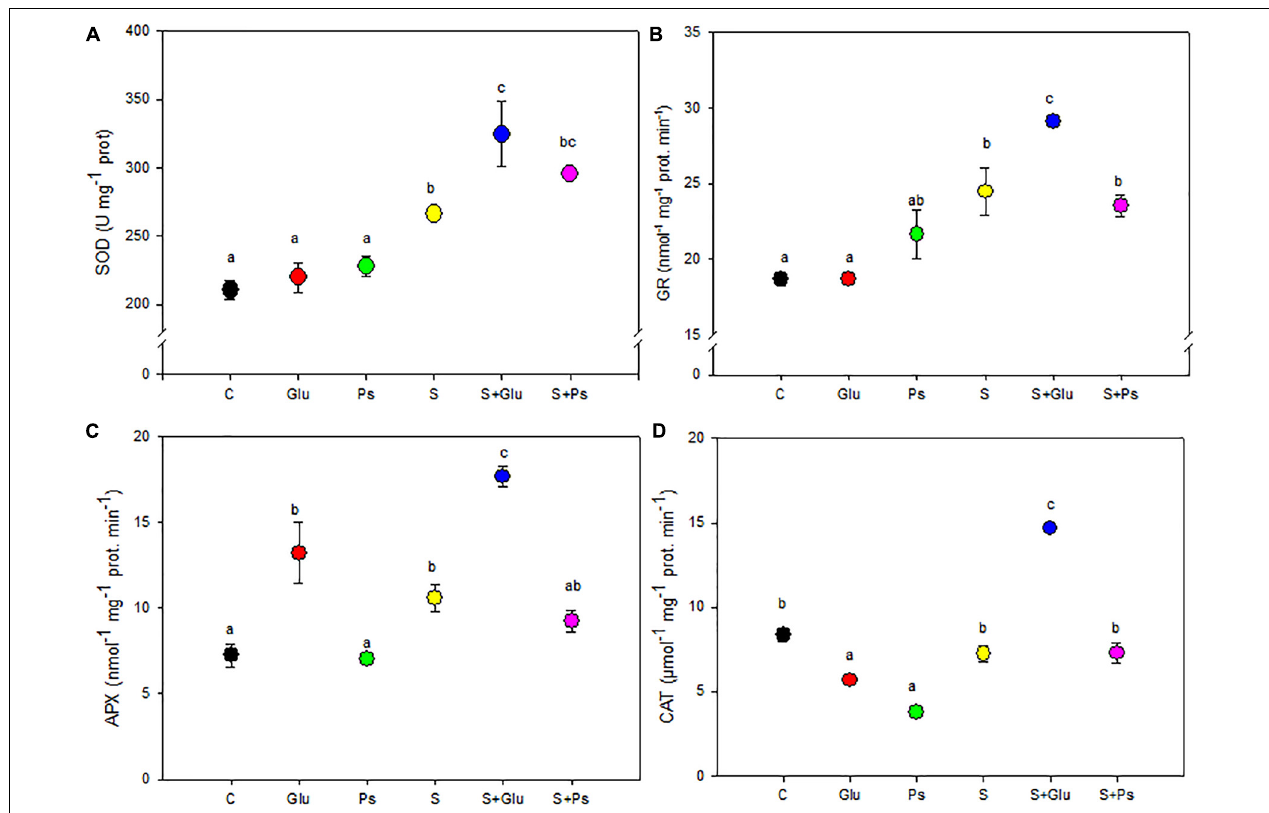
FIGURE 4 | Effect of bacterial inoculation on antioxidant enzyme activities: (A) superoxide dismutase (SOD), (B) glutathione reductase (GR), (C) ascorbate peroxidase (APX), and (D) catalase (CAT) in leaves of S. fruticosa plants, in the absence (0 mM NaCl) and in the presence of NaCl (600 mM NaCl). Values are the means standard deviation of five replicates. Values sharing the different letters indicate significant differences between treatments at the 5% level